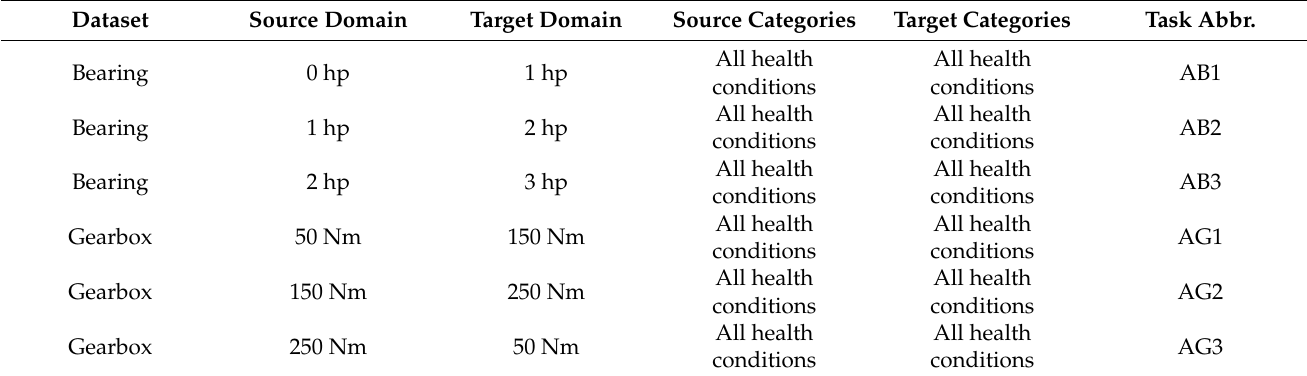
Table 7. Transfer learning scenarios of bearing and gearbox